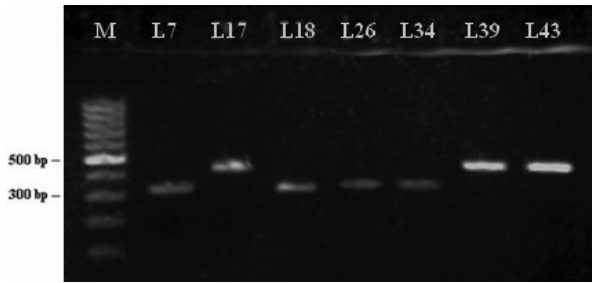
Figure 5. Gel electrophoresis pattern of some amplicons: a PCR product of 444 bp was amplified from Plenodomus biglobosus iso- lates L17, L39 and L43, and of 331 bp was amplified from P. lingam isolates L7, L18, L26 and L34. M indicates the GeneRuler 100 bp DNA ladder (Thermo Scientific).